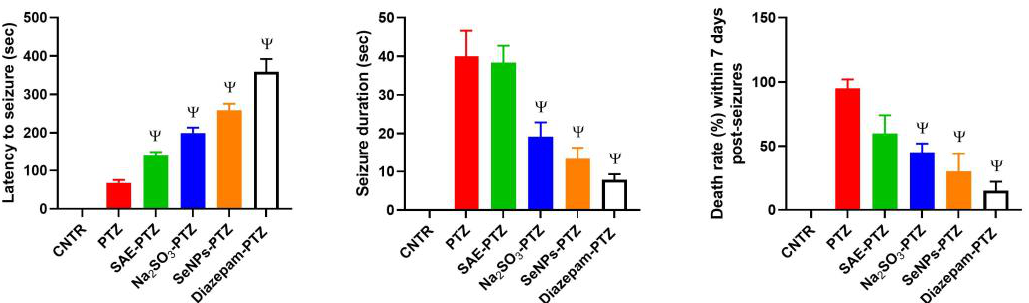
Figure 2. Effects of oral administration of Syzygium aromaticum extract (SAE), sodium selenite (Na 2 SeO 3 ), and green synthetized SeNPs using SAE (SAE-SeNPs) on the seizure duration, latency to seizures, and death rate following pentylenetetrazol (PTZ)-induced epileptic seizures ( n = 8). Ψ indicates significant differences ( p < 0.05) compared with the PTZ-exposed group. All data are presented as the mean ± standard deviation (SD).